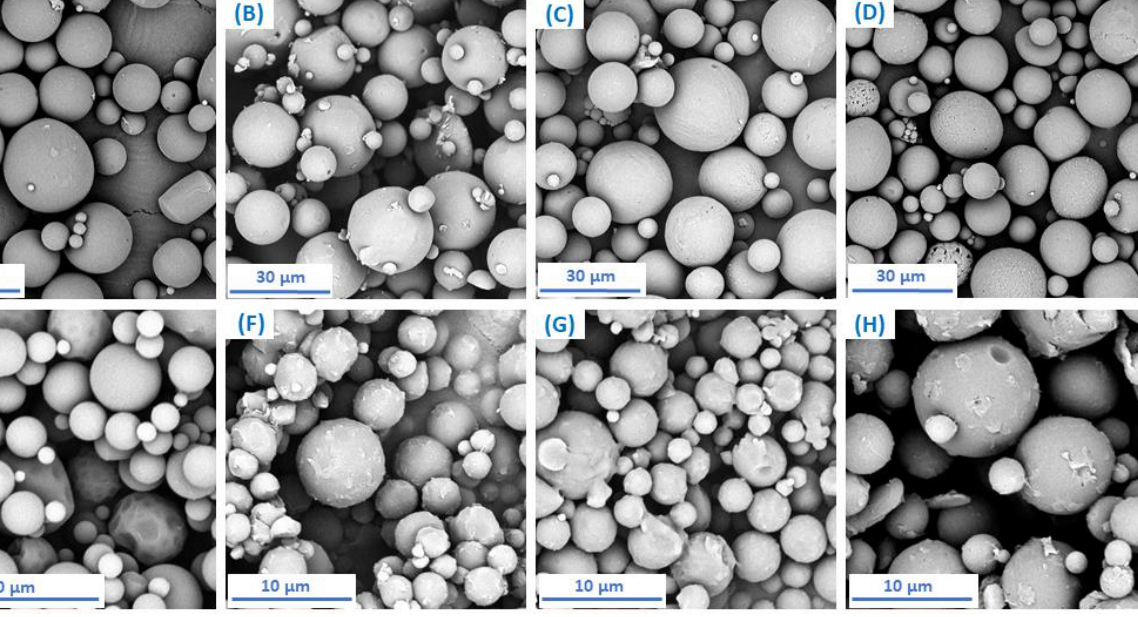
Table 6. Microsphere size, actual and theoretical loading, encapsulation efficiency and drug loading